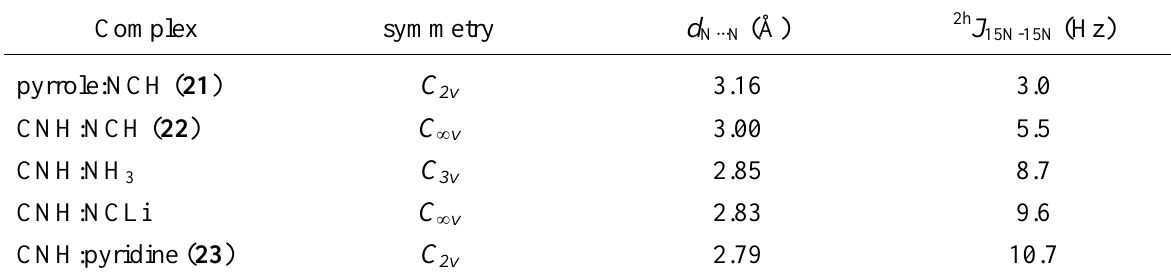
coupling constants 15N-15N